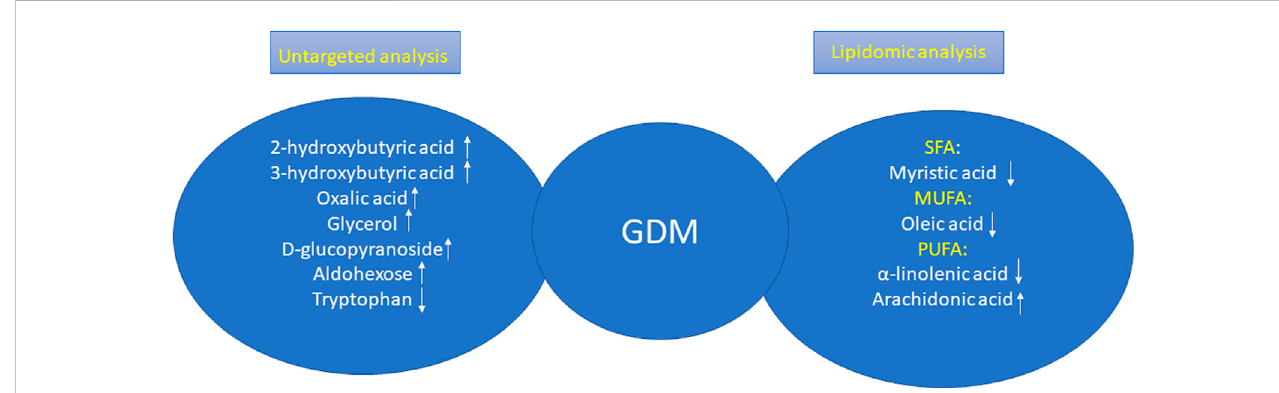
FIGURE 5 Changes in GDM women according the results obtained during untargeted analysis and lipidomic